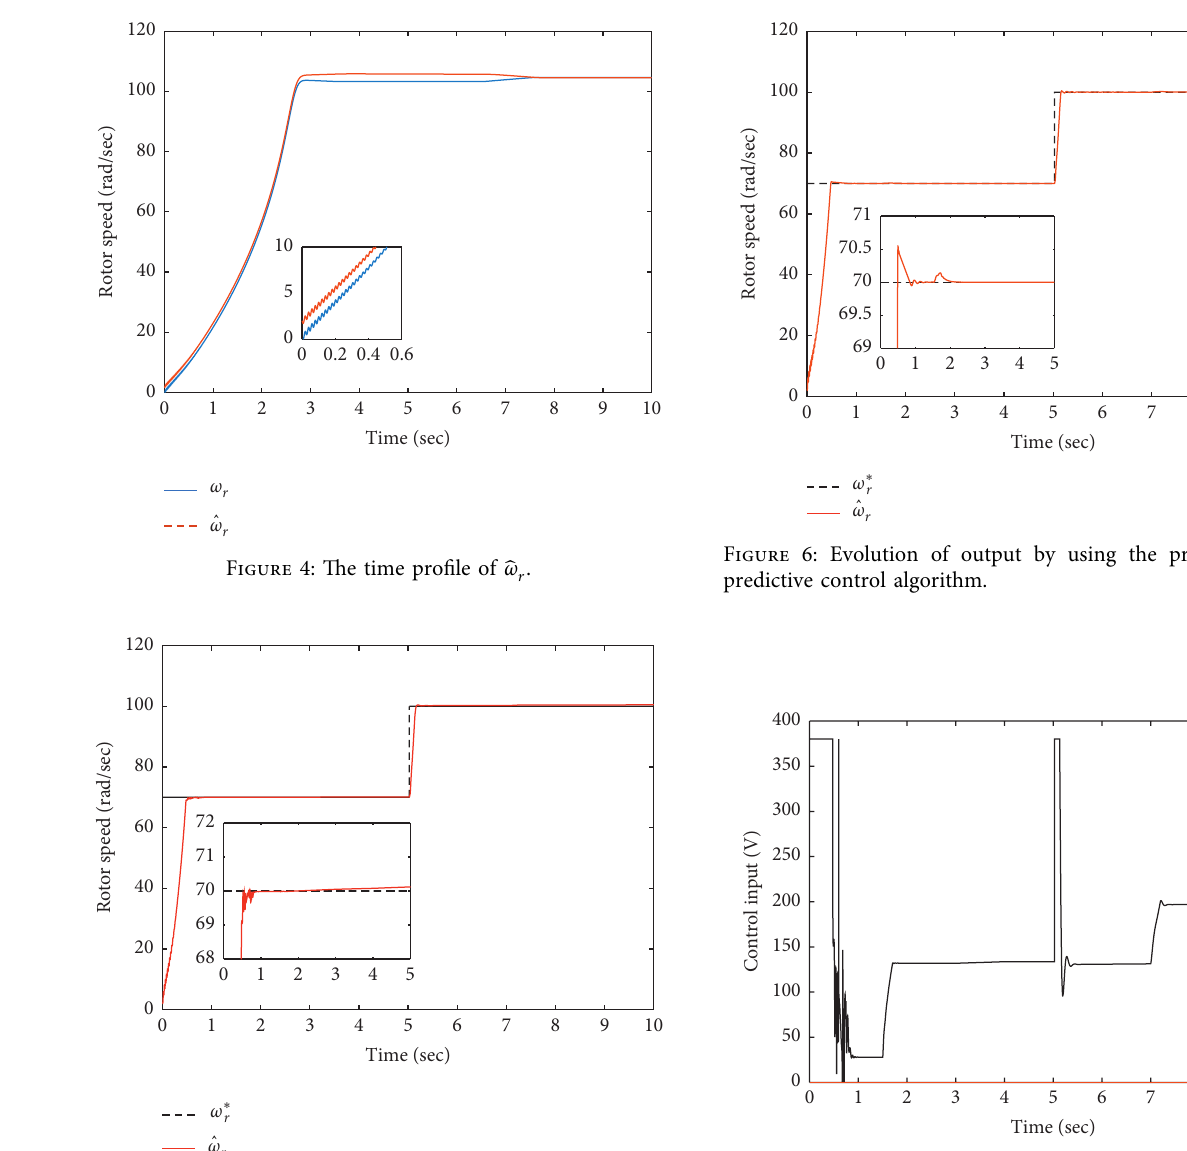
Figure 5: Evolution of output by using the proposed super-twisting control algorithm.